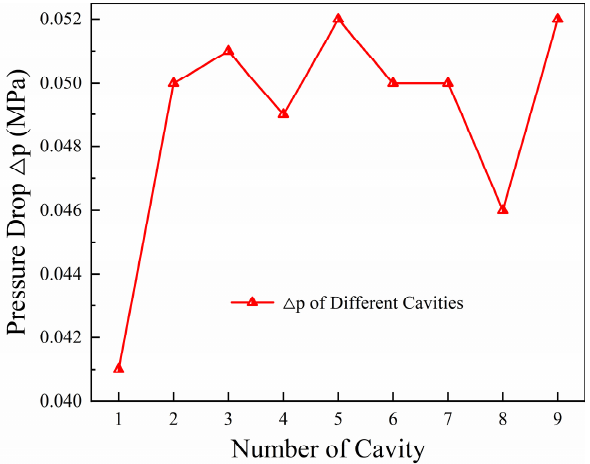
Figure 10. Pressure drop in the positive y-direction.